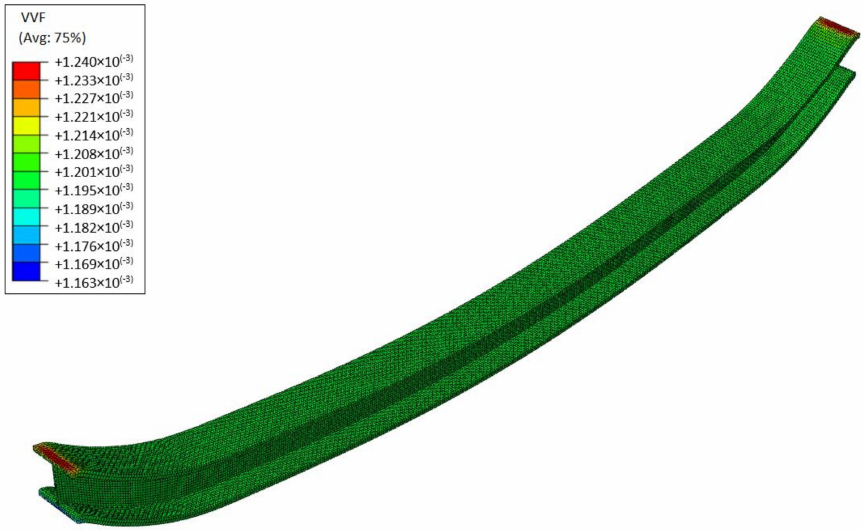
Figure 18. Void volume fraction map for the steel beam at the end of the deformation